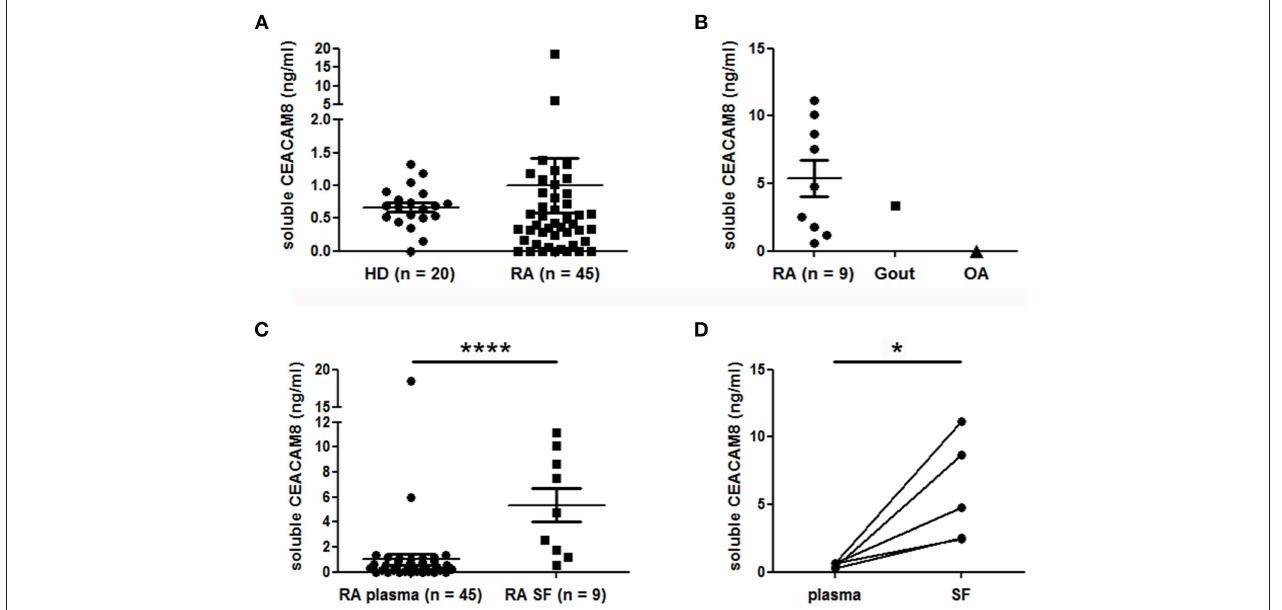
FIGURE 4 | Soluble CEACAM8 is enriched in inflamed tissue of patients suffering from rheumatoid arthritis. (A) Circulating soluble CEACAM8 concentrations were estimated by ELISA in the plasma of healthy donors (HD) and rheumatoid arthritis (RA) patients. (B) Concentrations of soluble CEACAM8 were determined in the synovial fluid of nine RA patients, one gout patient and one osteoarthritis (OA) patient. (C) Comparison of soluble CEACAM8 concentrations in all RA plasmas and all RA synovial fluids tested. (D) Comparison of soluble CEACAM8 concentrations in the plasma and the synovial fluid of five RA patients. Mean and SEM are presented. * p < 0.05; **** p <